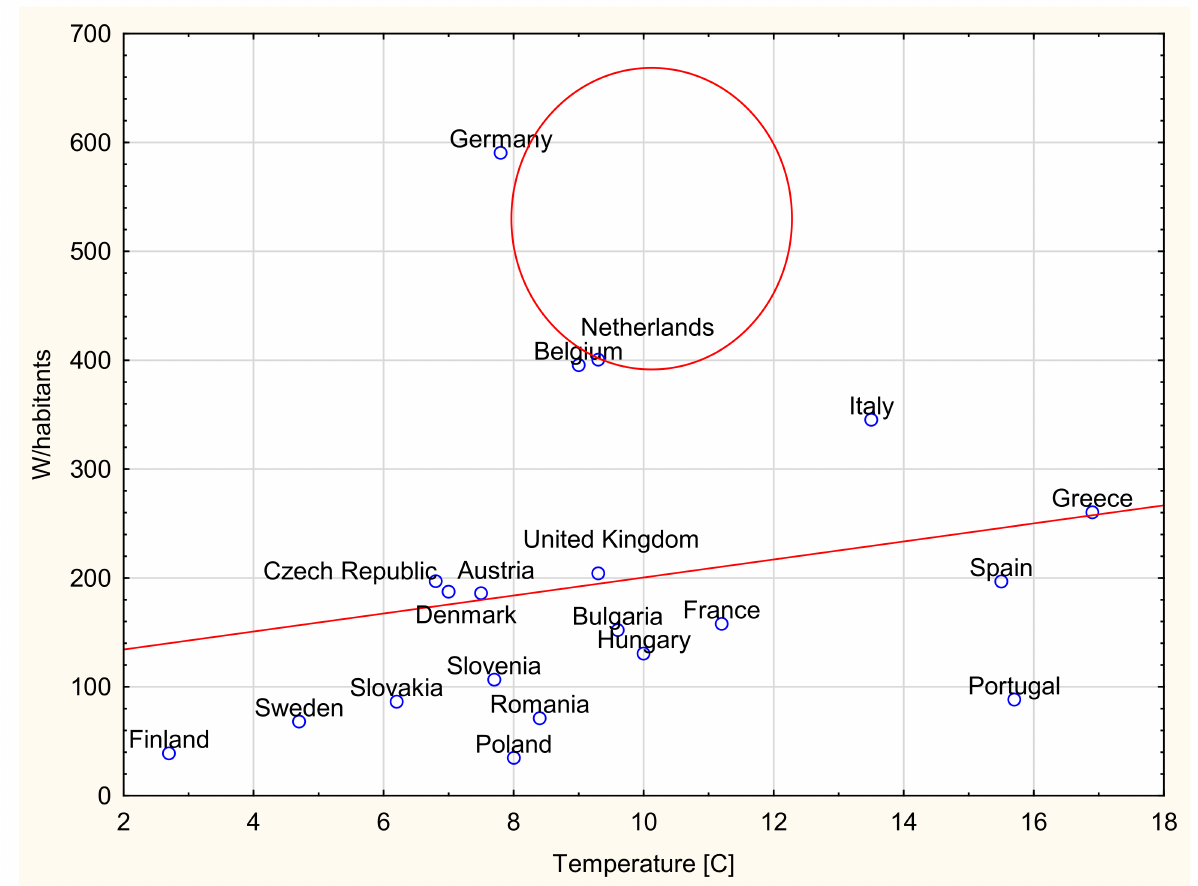
Figure 7. Relationship between national average temperature and W/inhabitant of photovoltaic power. Source: Authors’ own